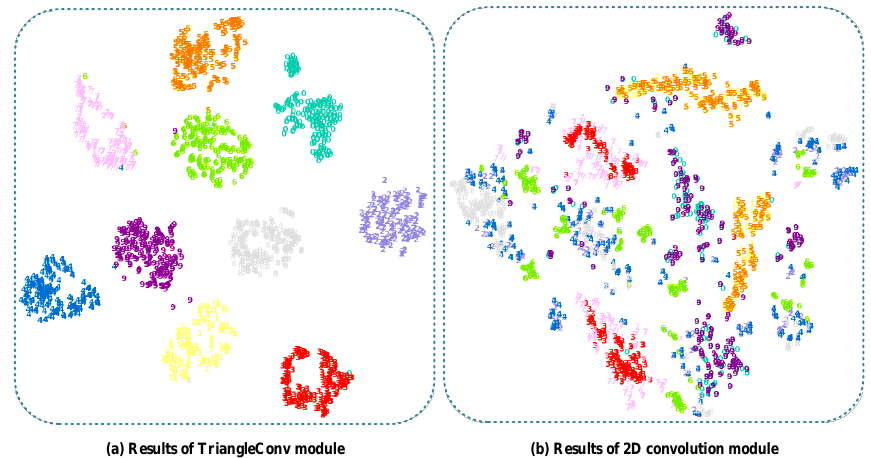
Figure 5. The clustering results by feeding the preprocessed data from 10 classes with 200 samples in each class into the 2D convolutional embedding module and the TriangleConv embedding module to obtain the embedding representation and clustering them with T-SNE method (PCA is used as the initialization method and random_state is set to 2020).